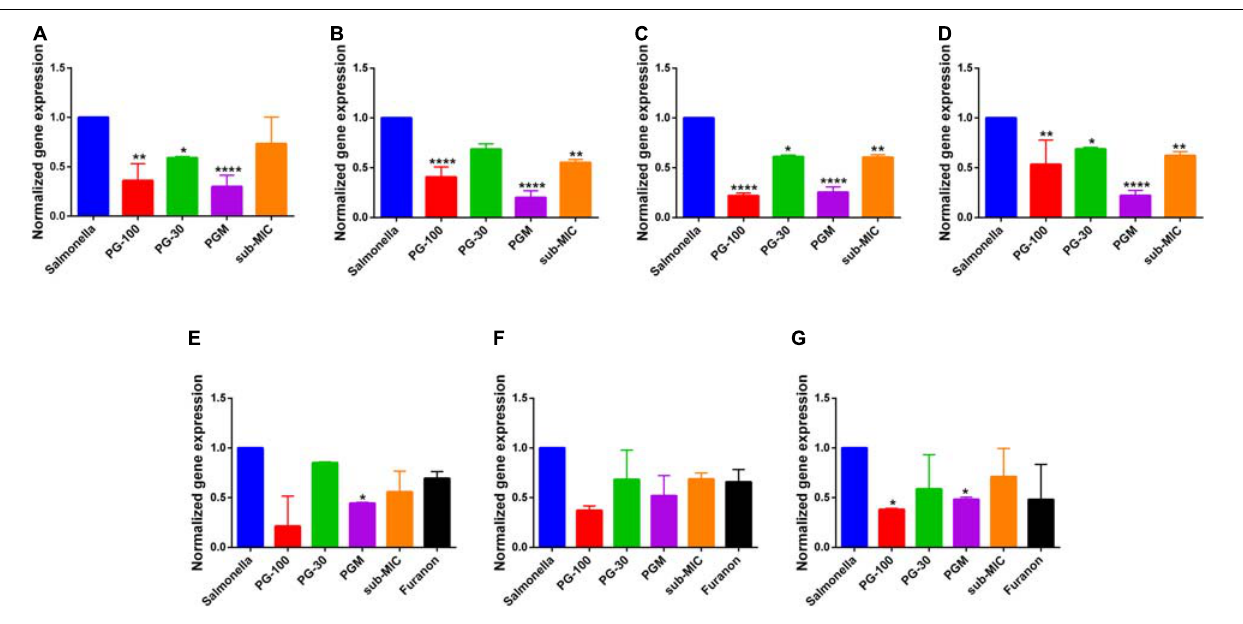
FIGURE 6 | Effect of pyrogallol on the expression of Salmonella invasion and quorum sensing virulence genes. (A) acrA (B) hilA (C) invF, (D) sipB, (E) sdiA (F) srgE, and (G) rck gene. Salmonella – untreated culture; PG-100 – treated with 100 µ g/mL of pyrogallol; PG-30 – treated with 30 µ g/mL of pyrogallol; PGM – treated with a combination of 30 µ g/mL of pyrogallol and sub-MIC of marbofloxacin; sub-MIC – treated with sub-MIC of marbofloxacin alone. For the quorum sensing gene expression assay all groups are treated with N-Acyl homoserine lactone (AHL, 1 µ mol/mL). * P < 0.05; ** p < 0.01; **** P <